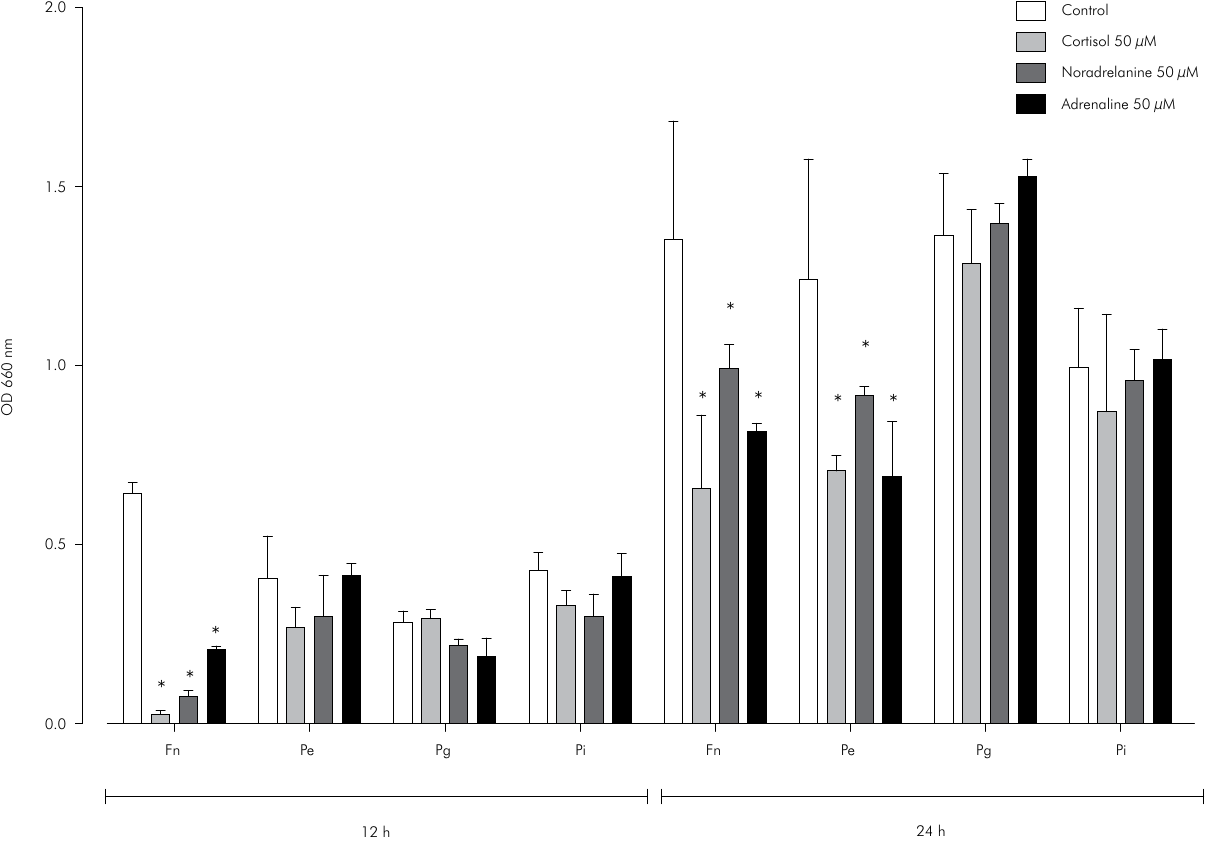
Figure 2. Mean and standard deviation of optical density (660 nm) representing the bacterial growth. Statistically significant p values are shown (*) on the upper side of the columns ( p < 0.05, Kruskal Wallis,